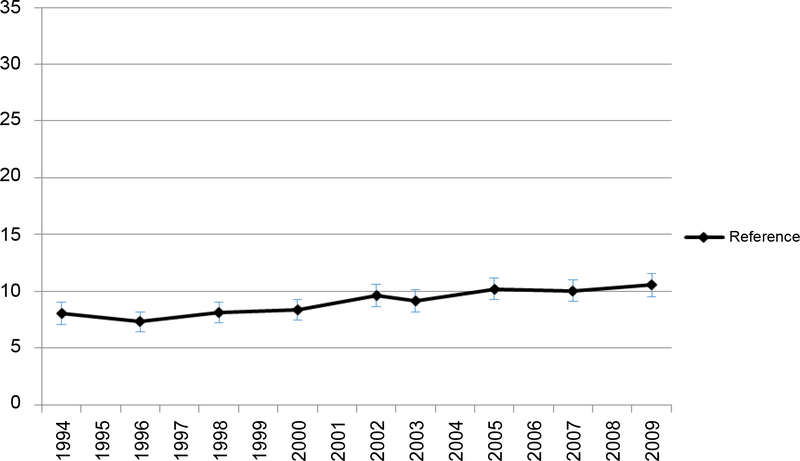
Predicted prevalence of FV5/day of the reference group (obese, male, age 18–39 years, black, < HS, obese, < 25k income, divorced/separated, Midwest Census Region).